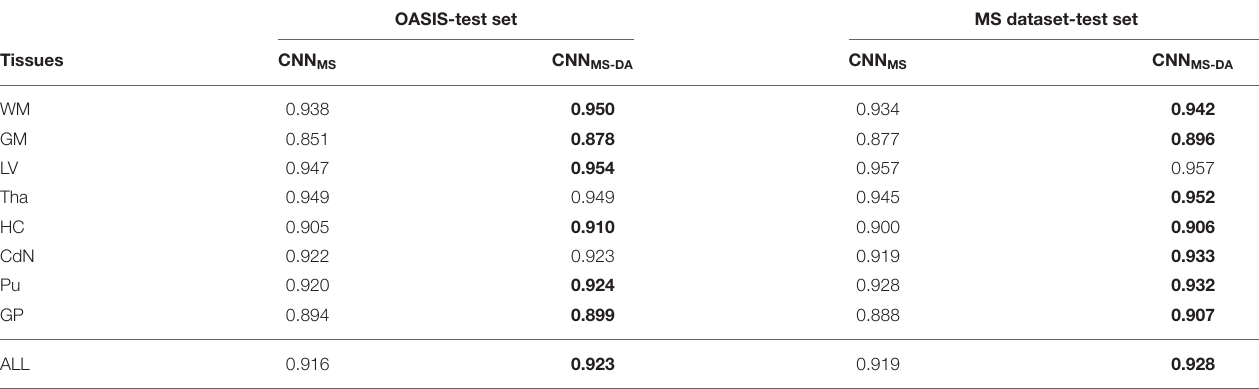
TABLE 3 | Summary of the Dice score (DC) performance of models trained on the MS dataset (CNN MS and CNN MS - DA ) and tested on the OASIS and MS dataset test sets. OASIS-test set MS dataset-test